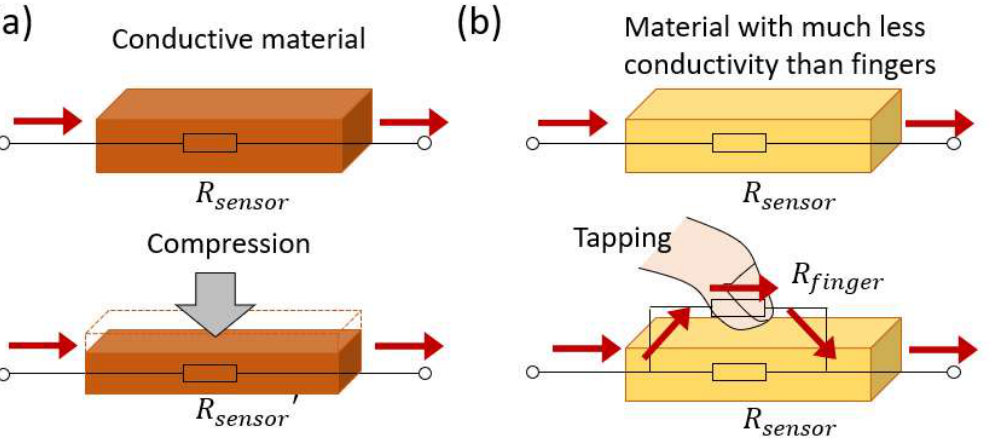
Figure 2. The mechanism for detecting a touch. ( a ) The conventional touch-detection mechanism used by sensors in previous works: physical compression causes material deformation, which leads to a change in the electrical resistance. ( b ) The proposed touch-detection mechanism: a finger contacting a less conductive material partially short-circuit the conductive path and significantly alters the measured signals.